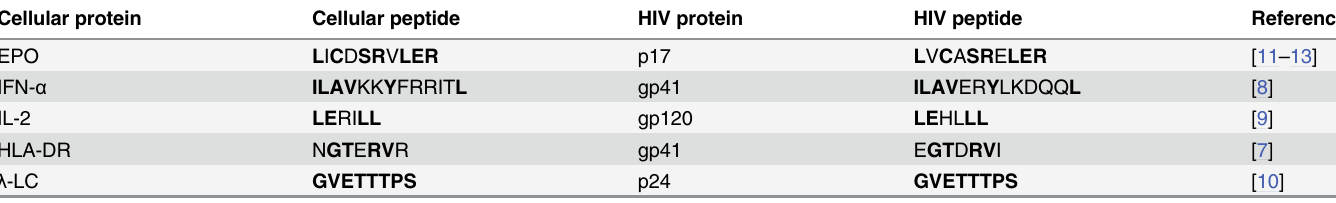
Table 1. Proposed cellular targets of molecular mimicry in HIV subjects. Cellular